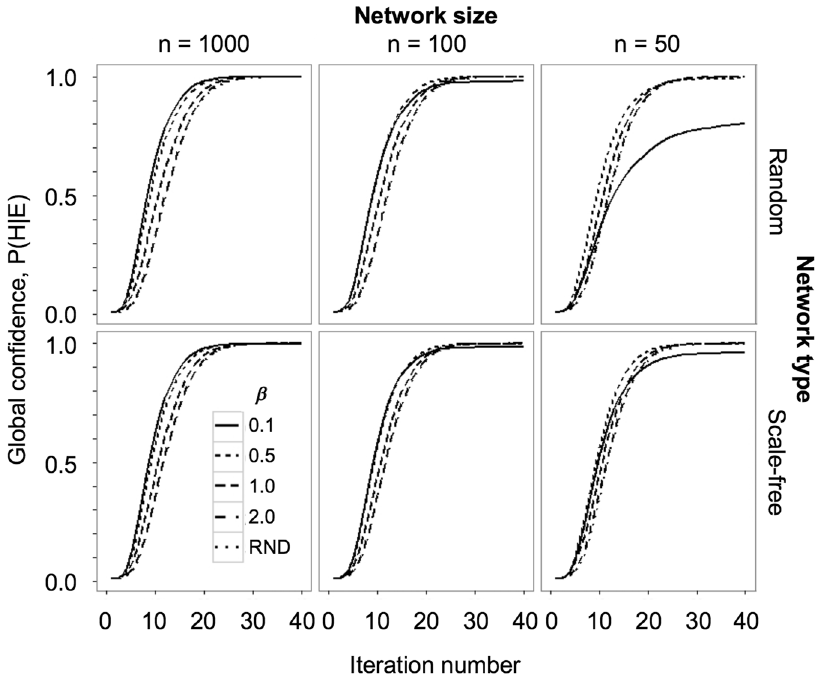
Figure 2. The evolution of confidence as a product of variance ( σ own ) for six simulations. Top row is stochastic placement, bottom row is Scale-Free placement ( γ = 2.5). Columns depict reach in stochastic placement ( α = 0.05, 0.1, ανδ 1) and number of agents in Scale-Free placement (n = 50, 100, 1000). β -values range from strongly confirmatory to unused ( β = 0.1, 0.5, 1.0, 2.0, and